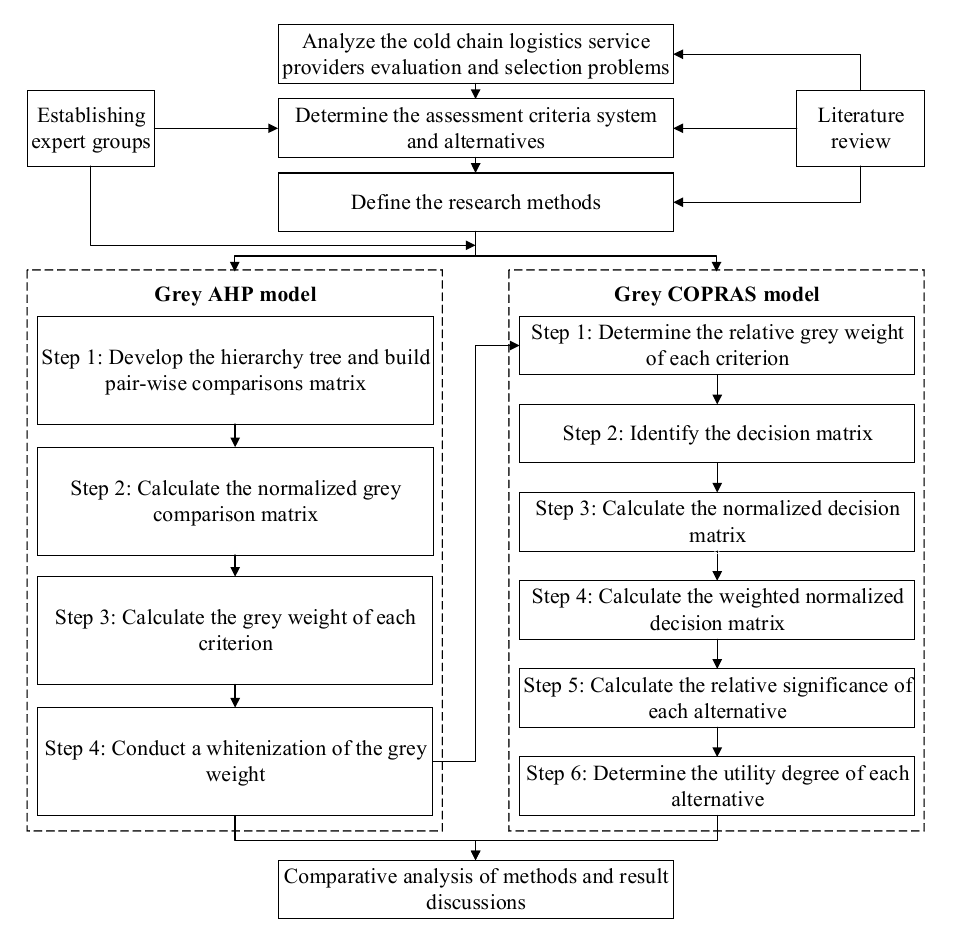
Figure 1. The research framework of this study.